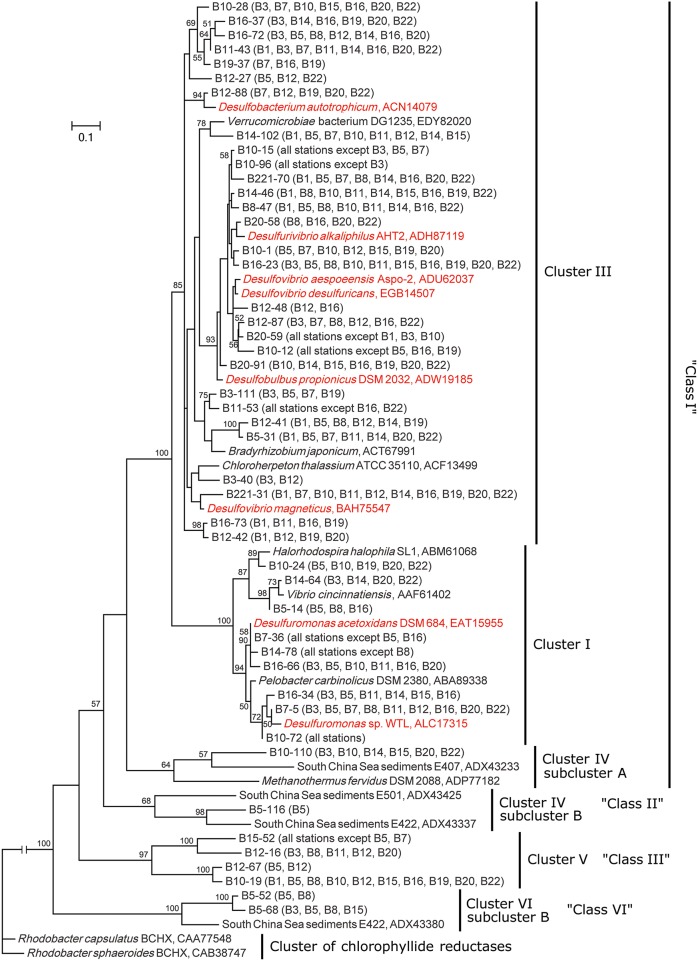
Phylogenetic tree of the major Bohai Sea sediment NifH sequences constructed with the neighbor-joining method. The NifH sequences of the most abundant OTUs (no <5 clones) were used for tree construction. The tree branch distances represent the amino acid substitution rate, and the scale bar represents the expected number of changes per homologous position. Bootstrap values higher than 50% of 100 resamplings are shown near the corresponding nodes. The chlorophyllide reductase iron protein subunit BchX sequences from Rhodobacter capsulantus and R. sphaeroides were used as outgroup.